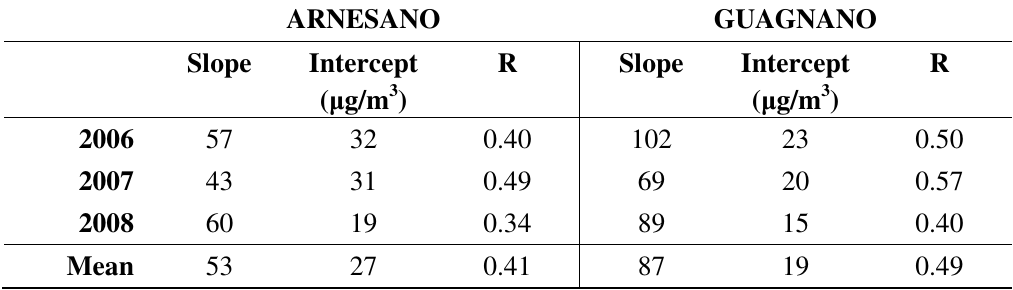
Table 3. Slope, intercept and linear correlation coefficient of the relationship between PM10 mass concentrations and clear-sky MODIS AOTs at Arnesano and Guagnano in 2006, 2007, and